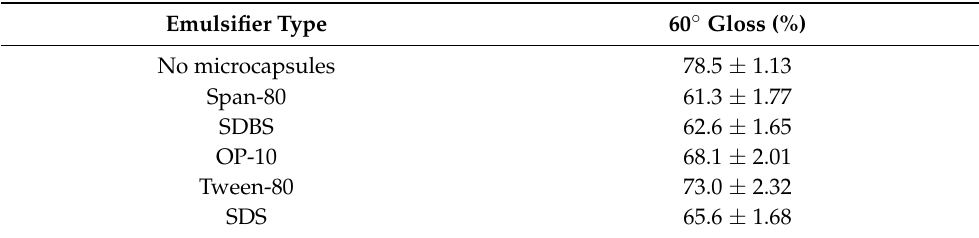
Table 5. Effect of emulsifier on gloss of coating